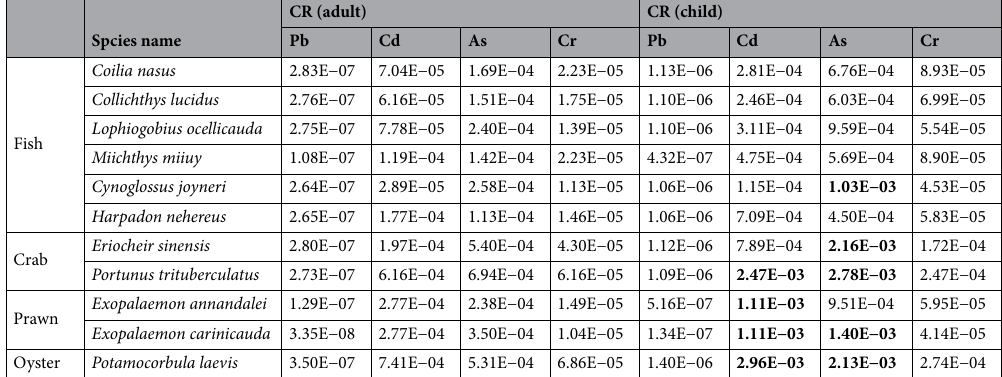
Table 2. Human carcinogenic risks (CR) through the consumption of targeted species. (Values in bold denote the terrible CR